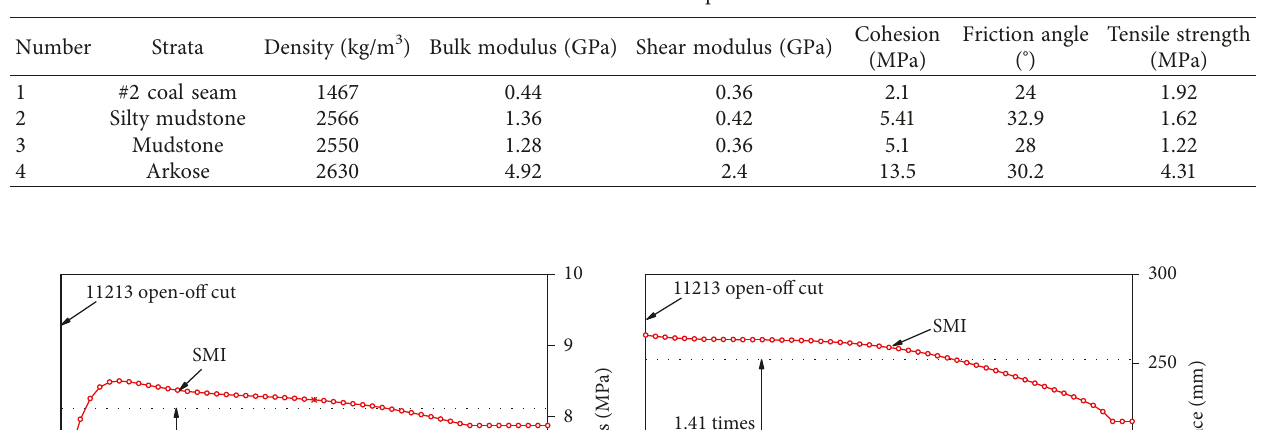
Table 1: Rock mechanical